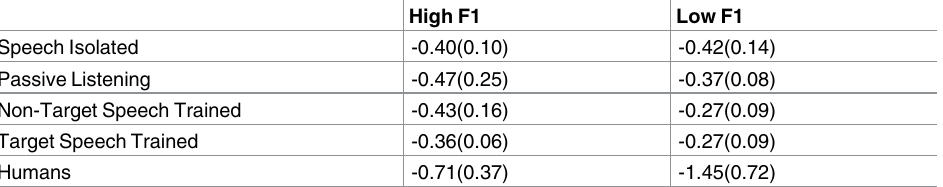
Table 3. Mean slopes in probit units per ms of VOT. (Numbers in parentheses are standard